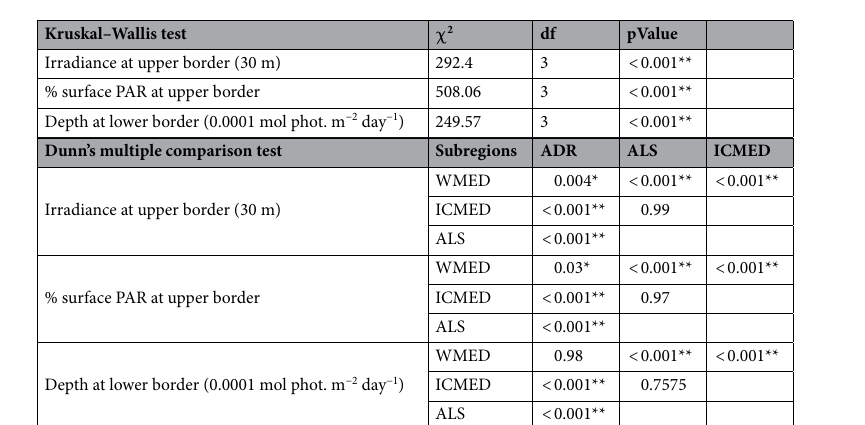
Figure 4. Depth and light ranges of the estimated mesophotic zone. Boxplots showing the irradiance (mol photons m −2 day −1 ) ( A ) and the percentage of PAR light ( B ) at the upper mesophotic limit (i.e., 30 m water depth) for the different Mediterranean sub-regions; ( C ) reports the depth corresponding to the lower mesophotic limit (i.e., at 0.0001 mol photons m −2 day −1 irradiance) for the Mediterranean sub-regions. The red boxes represent the values for the entire basin. Letters refer to statistically significant differences obtained with Kruskal–Wallis and Dunn’s multiple comparison tests (Table 1). Within each box the horizontal line represents median value. Boxes extend from the 25th to the 75th percentile. The vertical lines indicate the most extreme values within 1.5 interquartile range of the 25th and 75th percentile.